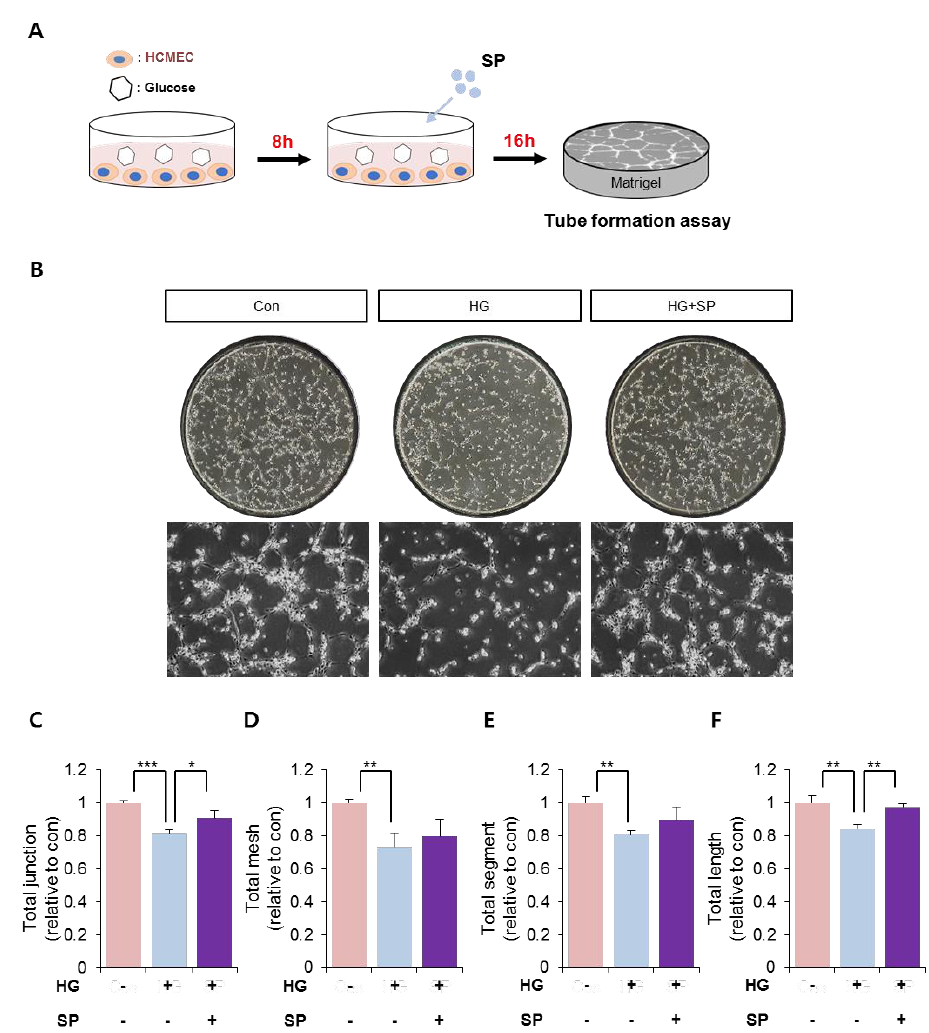
Figure 5. Hyperglycemia impairs the vascular structure-forming ability, which is restored via SP treatment. ( A ) Experimental scheme for glucose and SP treatment. ( B ) A representative image of CMECs cultivated on Matrigel. CMECs were subjected to Matrigel assays and the tube-forming ability was evaluated for 5 h. ( C – F ) Tube structures formed by CMECs were represented by total junction, mesh, segment, and length. Values of p < 0.05 were considered significant (* p < 0.05, ** p < 0.01, *** p < 0.001). The data are expressed as the mean ± standard deviation of three independent experiments. HG, high glucose; SP, substance-P; Con, control; CMECs, cardiac microvascular endothelial